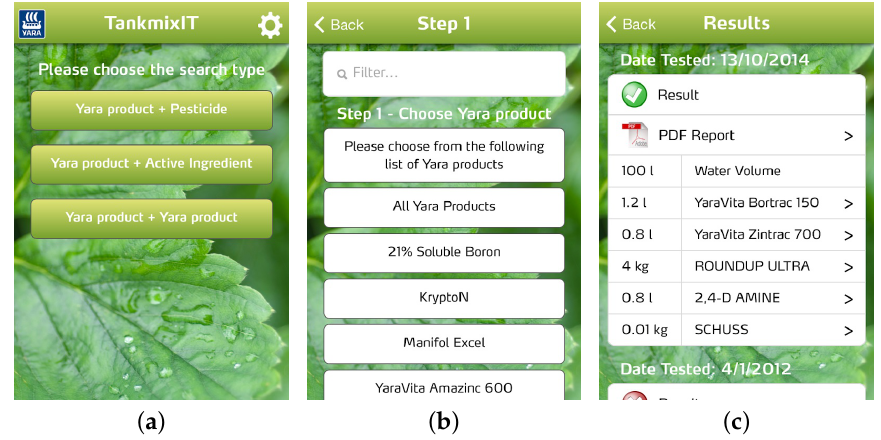
Figure 12. Yara TankmixIT: ( a ) Main menu; ( b ) Choose Yara product interface; ( c ) Mixing result